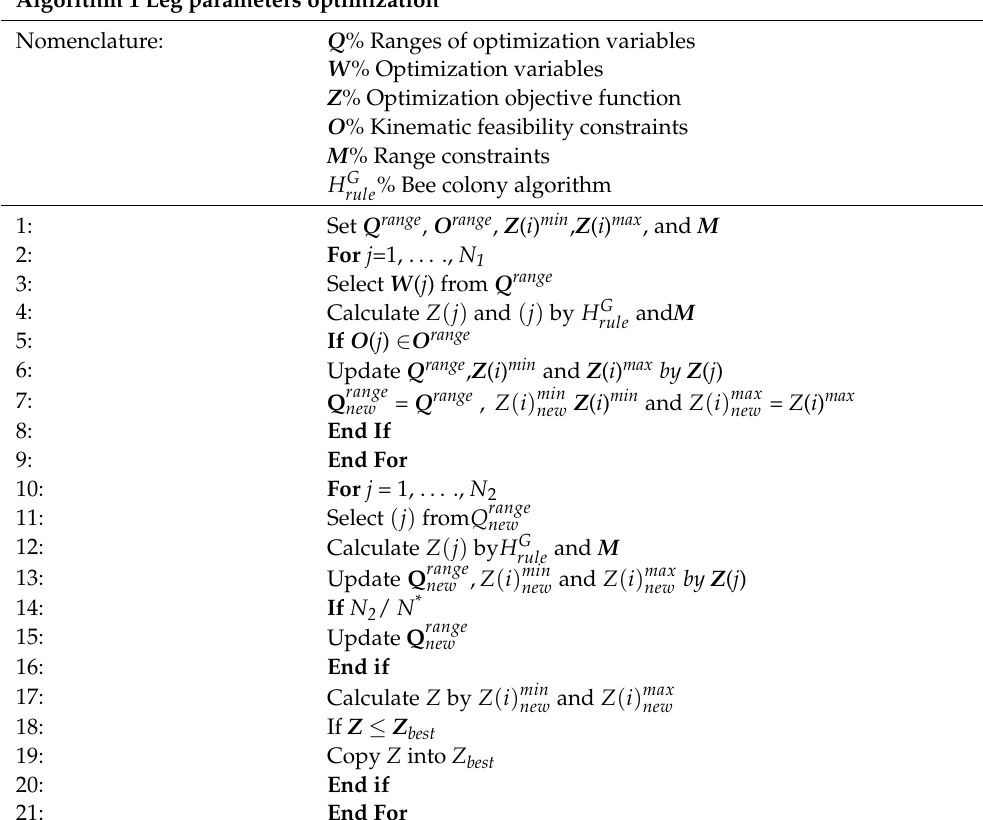
Algorithm 1 Leg parameters optimization